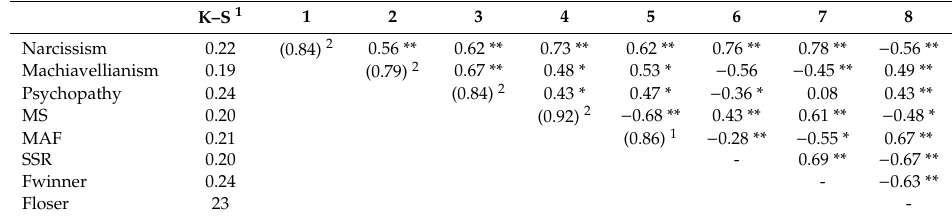
Table 3. Pearson´s correlations between dark personality traits, competitiveness and personal feelings about himself.